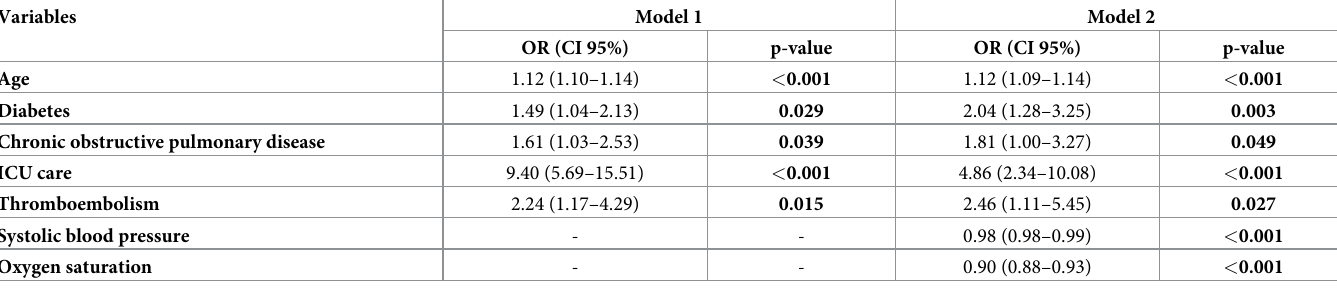
Table 3. Multivariate analysis and adjusted logistic regression for predictors of death.